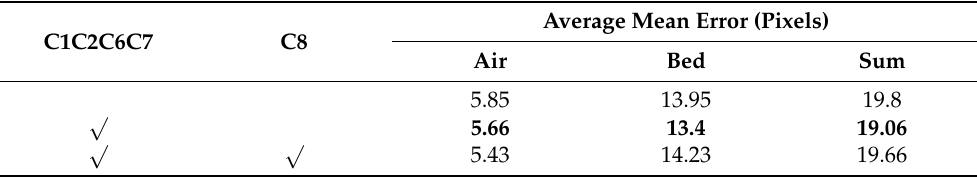
Table 6. Experiments with and without C8 unit in attention module. The symbol of ” means which method is